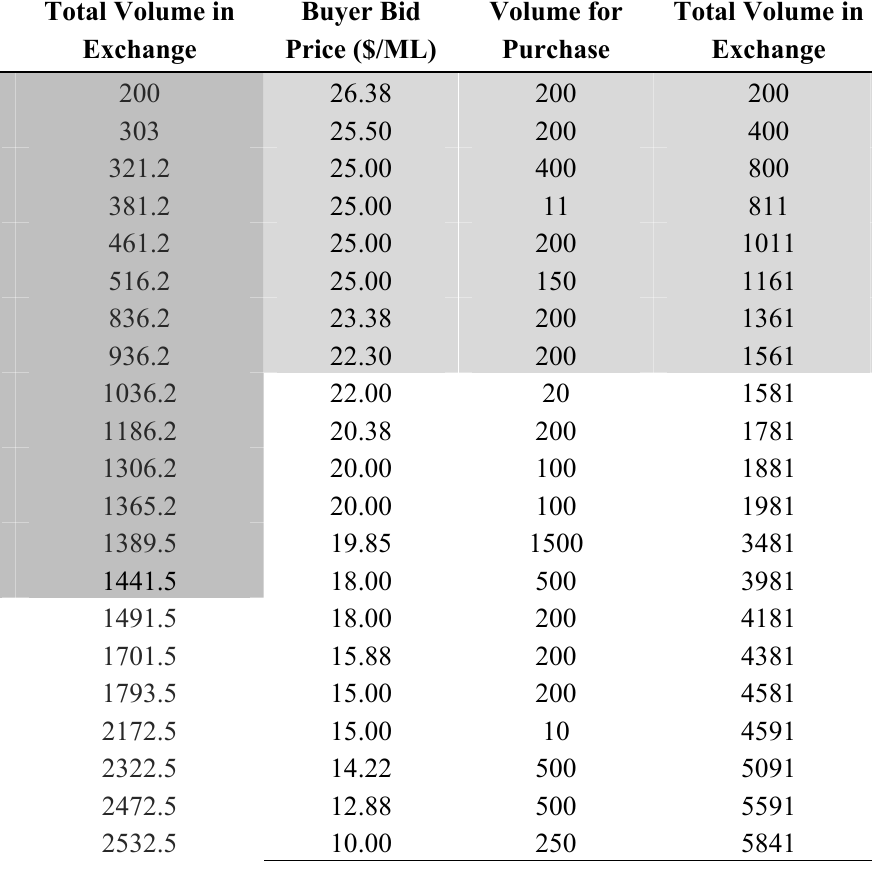
Pool price: $21.15/ML Total volume traded: 1441.5 ML (The shaded bids and offer orders were executed, with the buy